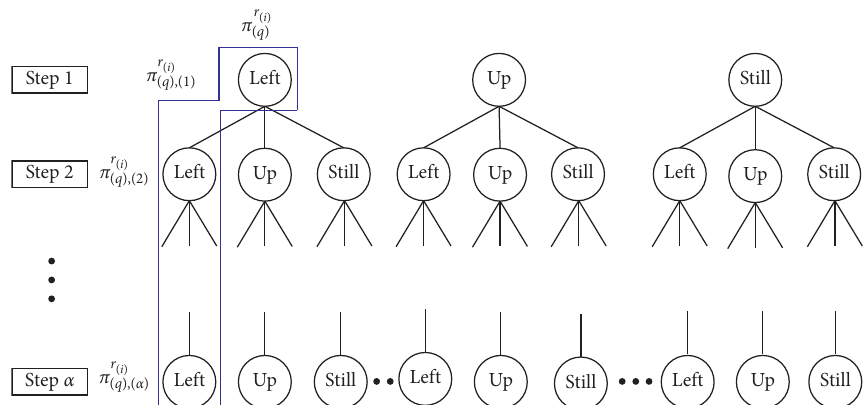
Figure 6: Generation of policy π r ( i ) for r ( i ) in each district. Assuming that the candidate actions in each district include left, up, and still, ( q ) for robot r ( i ) is shown in this figure. In this tree structure, different level of branches corresponds to the generation of policy π r ( i ) ( q ) different steps. Each circle represents the action for r ( i ) in the district at the corresponding time step. For example, the action left means from the first time step to the α th time step is illustrated in the blue that all the robots in the district should go left. A complete policy π r ( i ) ( q ) box. Multiple policies for each robot can be generated from this tree structure.